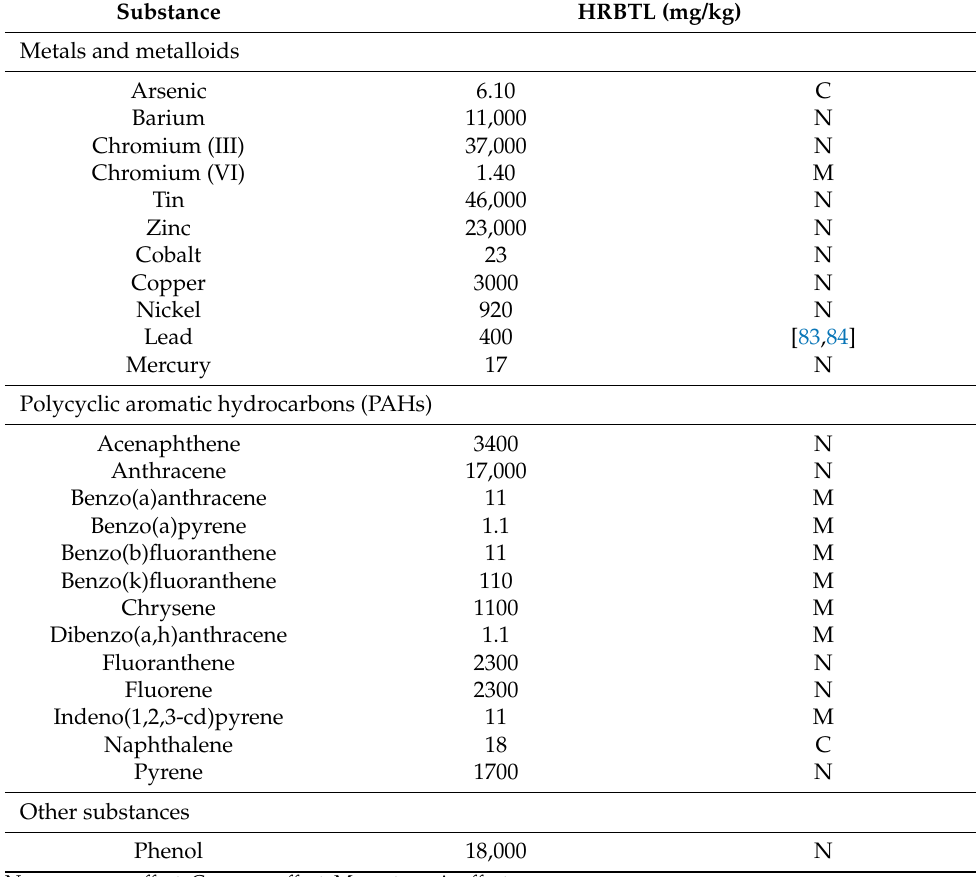
Table 11. Health risk-based target levels